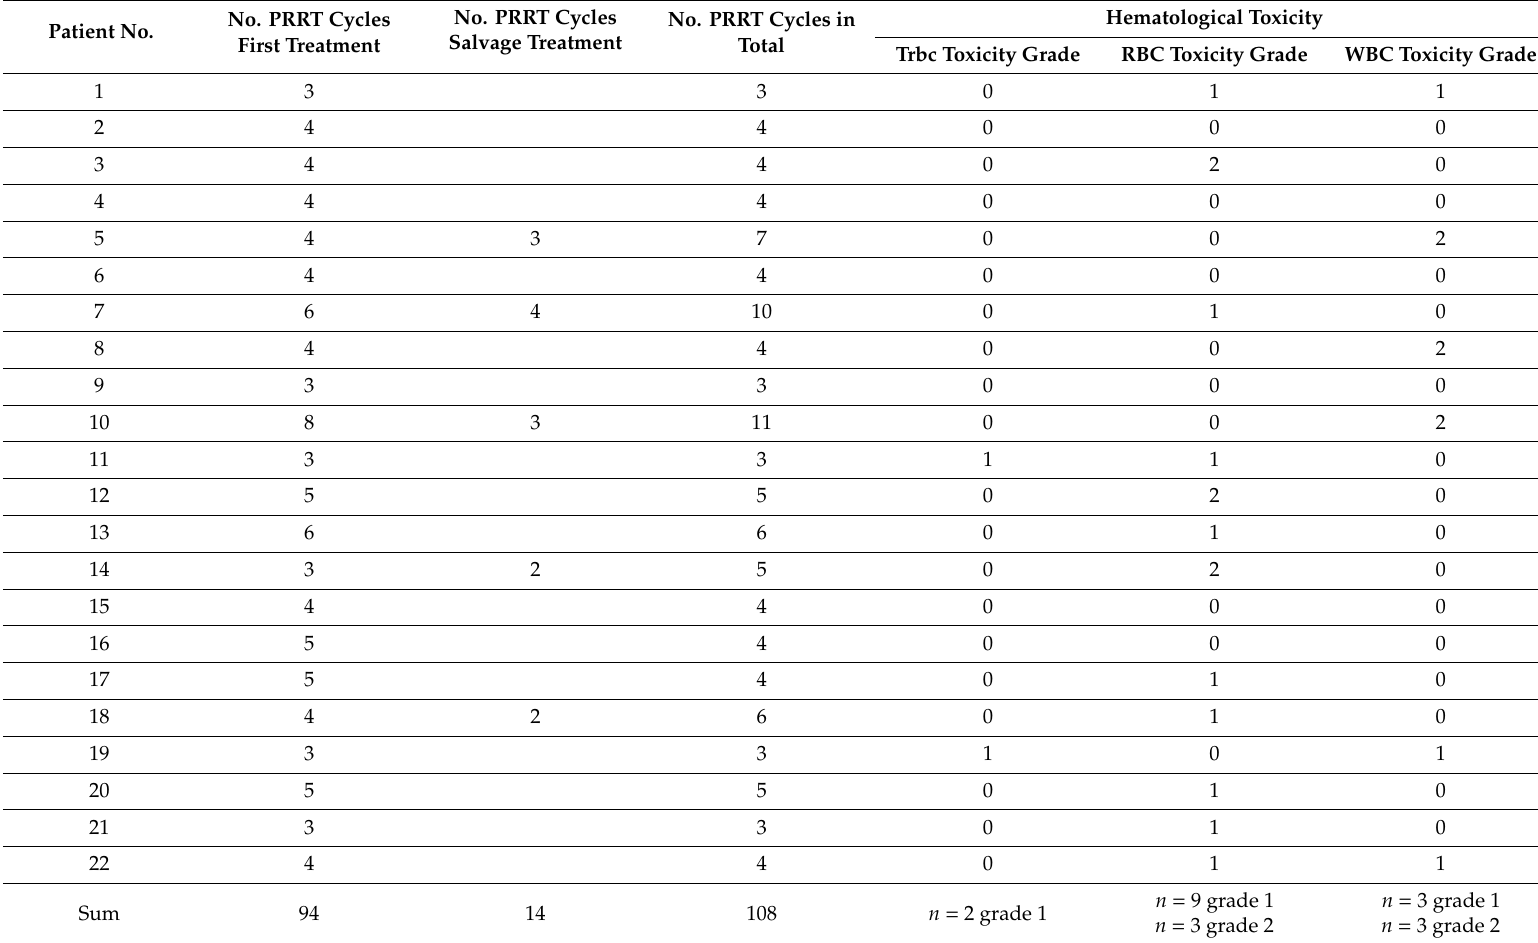
Table 2. Number of administered 177 Lu-DOTATATE cycles and hematological